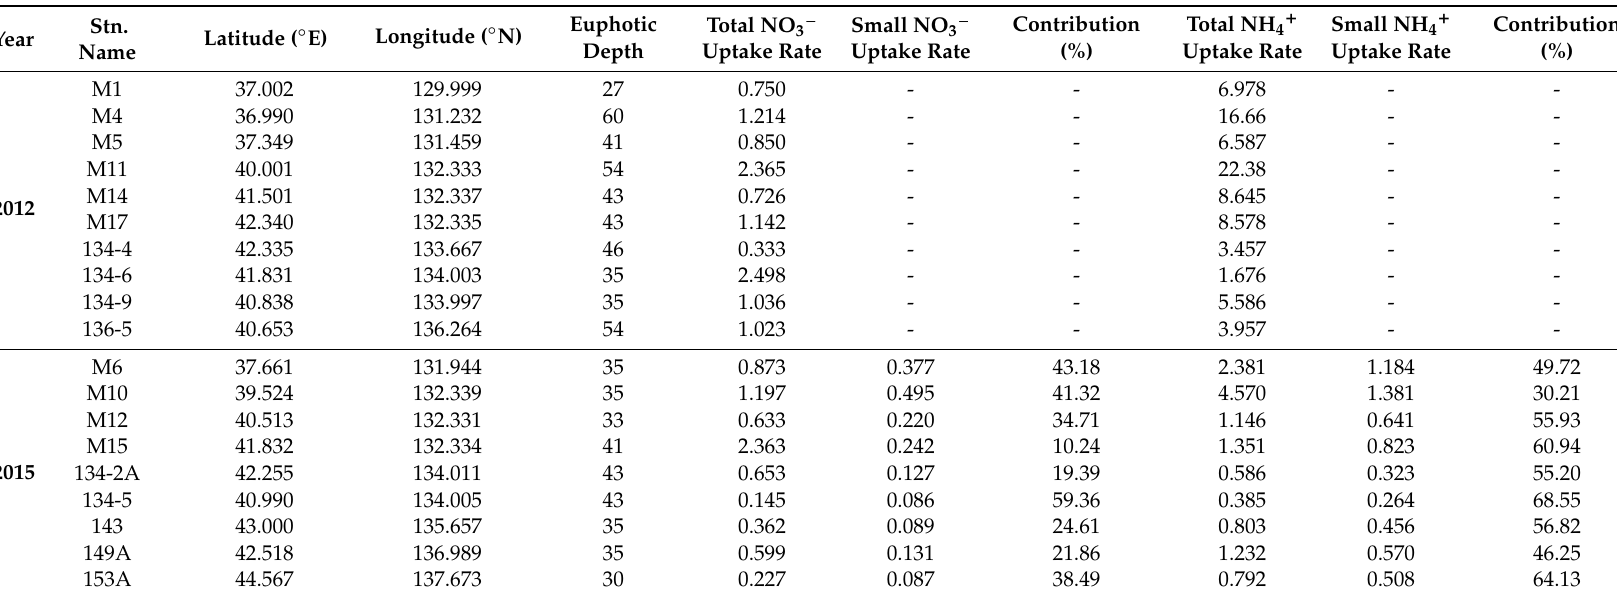
Table 2. The depth-integrated total and small phytoplankton uptake rates were obtained during the present study, where uptake rates were given in mmol N m − 2 h − 1 . Year